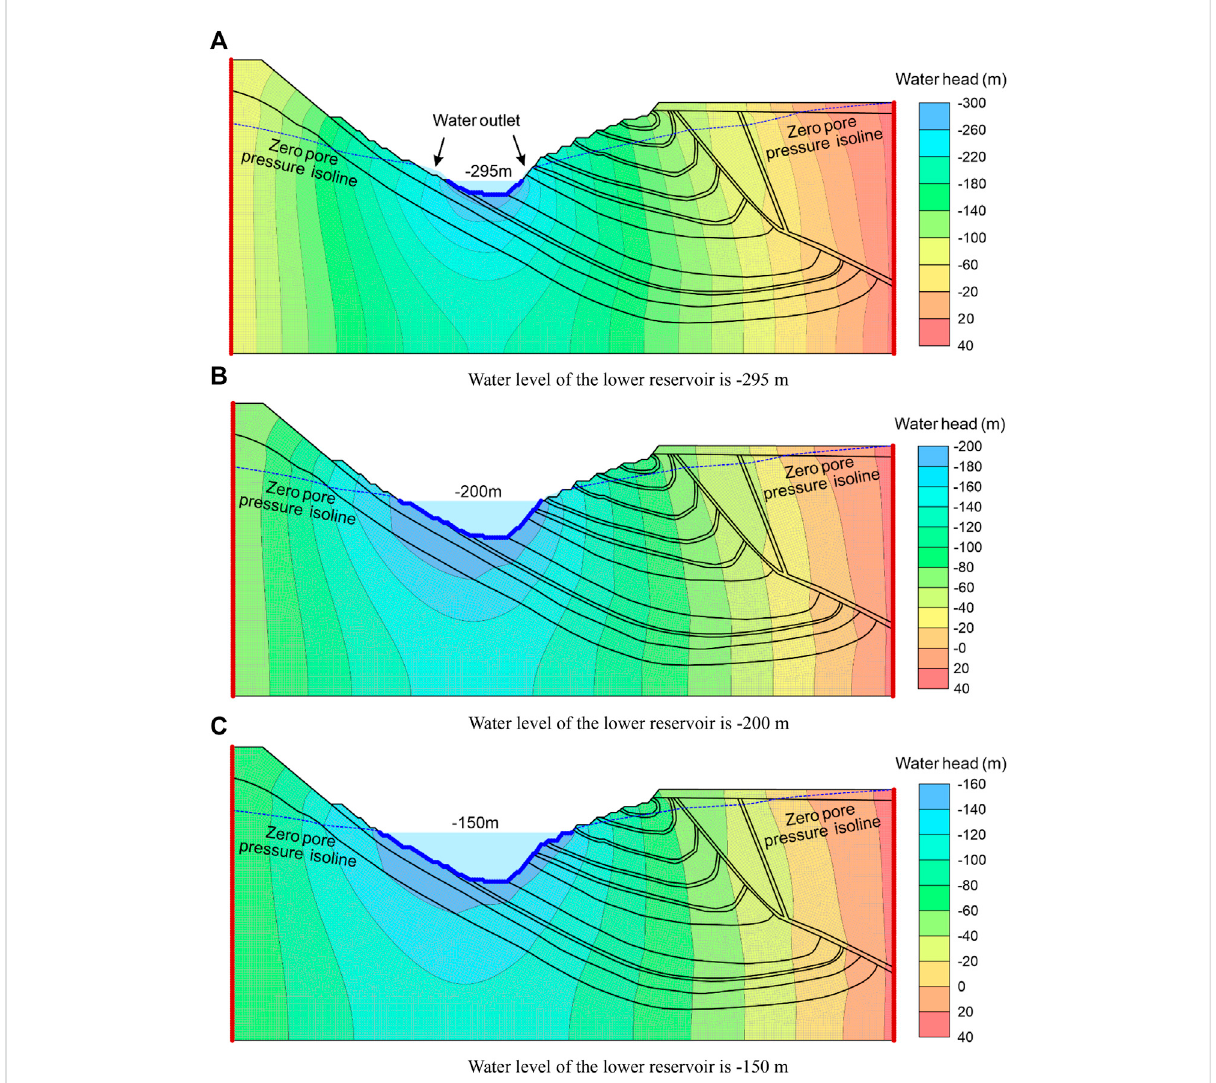
Figure 10. Poor rock mass quality and high zero pore pressure isoline are the main reasons for rock landslide in the Fushun West Open-Pit mine. Further imperviousness and reinforcement work is needed to improve the slope